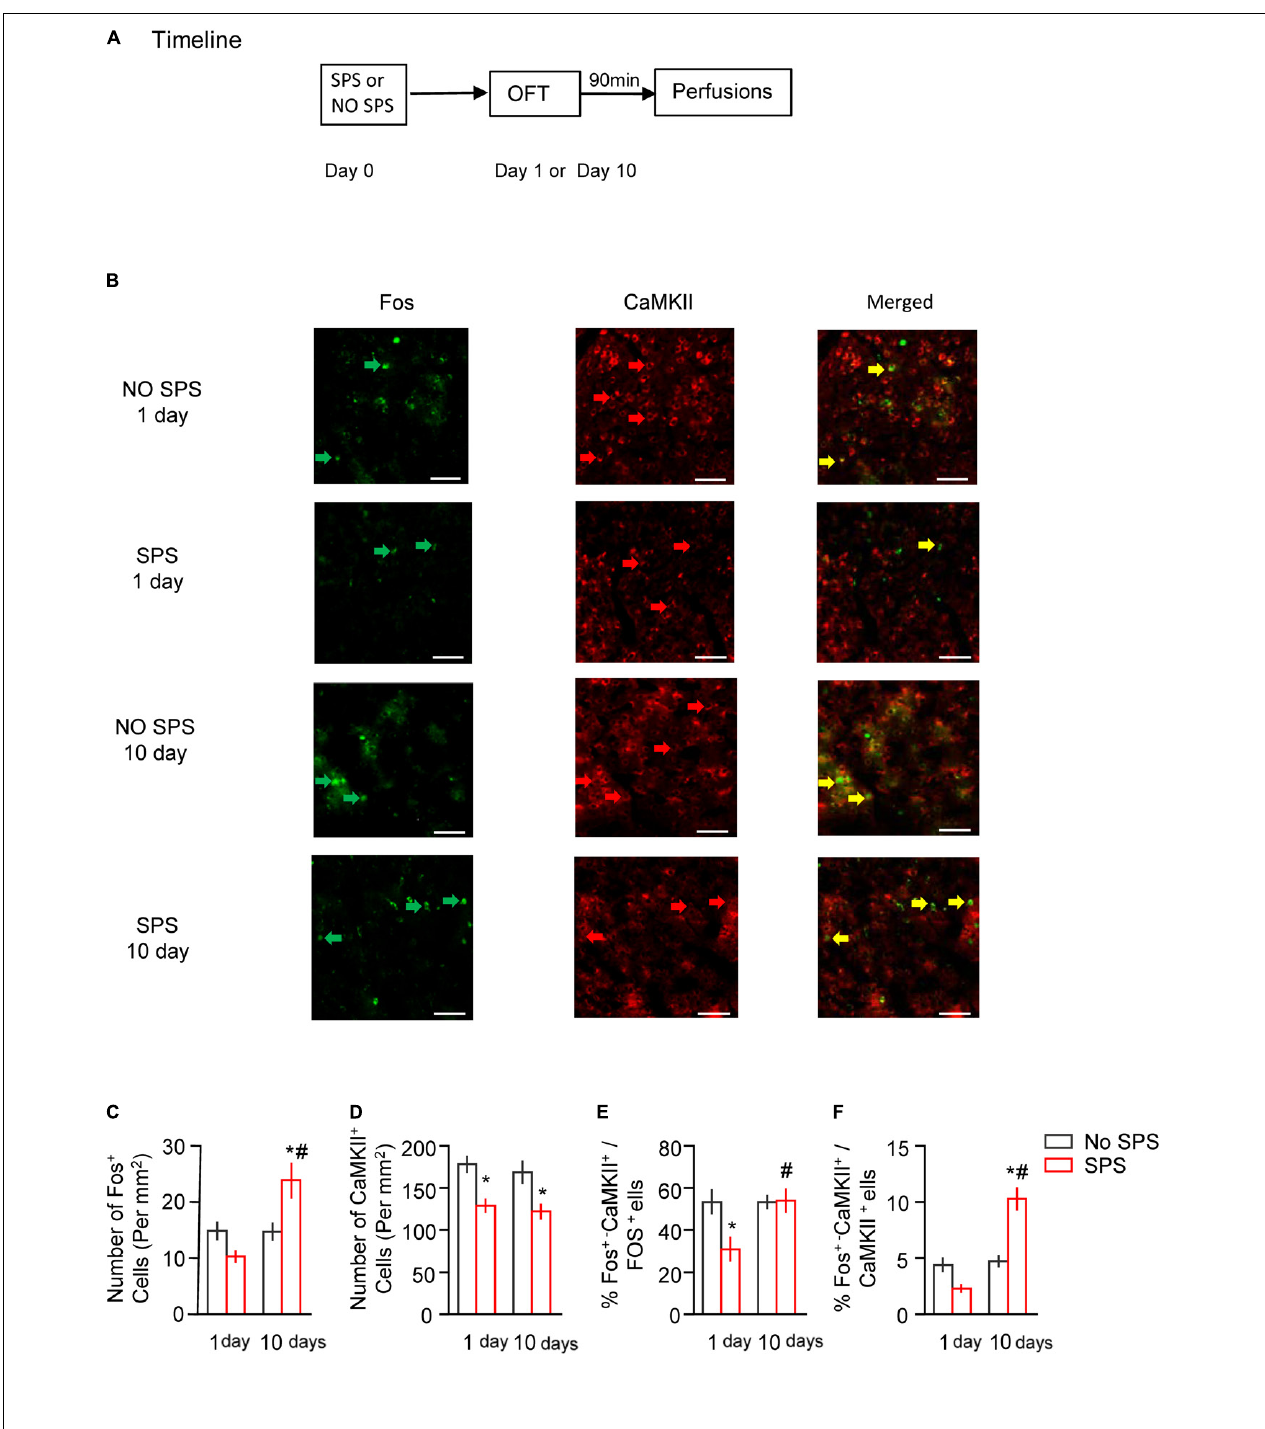
FIGURE 2 | Effect of single prolonged stress (SPS) on activation of glutamatergic neurons in BLA on day 1 or day 10 after stress. (A) Experimental procedures. We treated rats with SPS procedure, and performed perfusion and brain dissection 1 day or 10 days later. (B) Representative images showing green (Fos protein), red (CaMKII protein), and merged channels of double-label neurons in BLA in different experimental conditions. Scale bars represent 100 µ m. (C,D) Effect of the experimental manipulations on Fos protein (C) and CaMKII expression (D) in BLA. (E) Percentage of glutamatergic neurons in activated cells of BLA in different experimental manipulations, as calculated by number of overlap (Fos + CaMKII protein-IR)/Fos-IR. (F) Percentage of activated cells in glutamatergic neurons of BLA in different experimental manipulations, as calculated by number of overlap (Fos + CaMKII protein-IR)/CaMKII-IR. n = 6–8 per group. Data are mean ± SEM. ∗ Different from no SPS group at each post-stress day. # Different from SPS-1 day group, one-way ANOVA, p < 0.05.